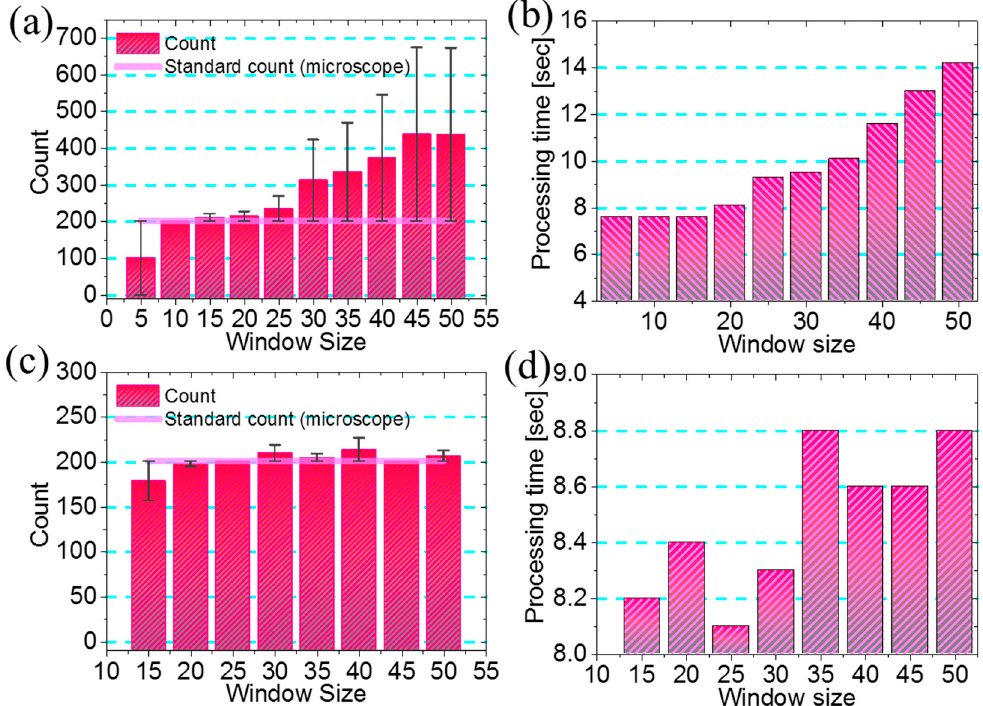
Figure 7. Optimization of the windowing method. ( a ) Window size vs. counting result for obtaining the local threshold; ( b ) window size vs. processing time for obtaining the local threshold; ( c ) window size vs. counting result for clustering of filtered binary image; ( d ) window size vs. processing time for clustering of filtered binary image.